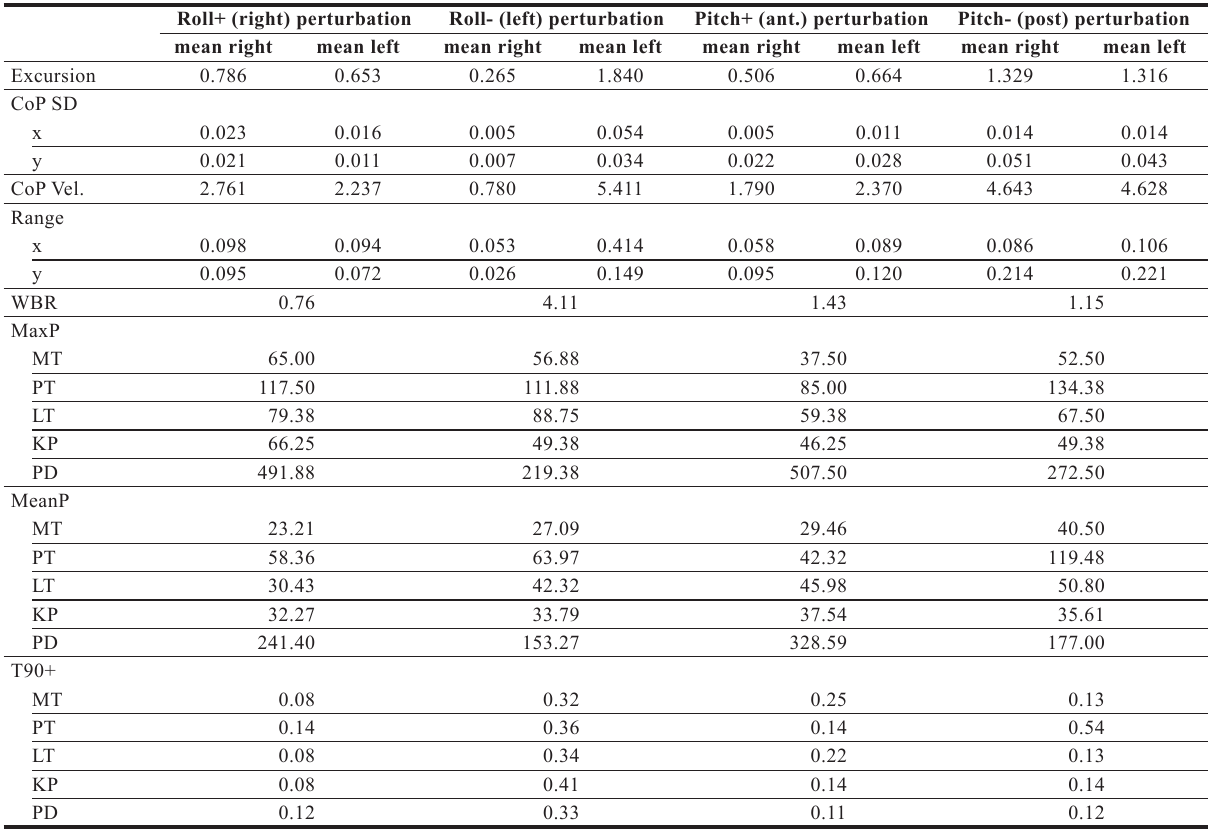
Table 1. Summarized CoP and Pressure mean values for each perturbation. Excursion, Range and CopSD are calculated in m , while CoP Velocity is calculated in m/sec . WBR and t 90+ has arbitrary units. Both MaxP and MeanP are measured in